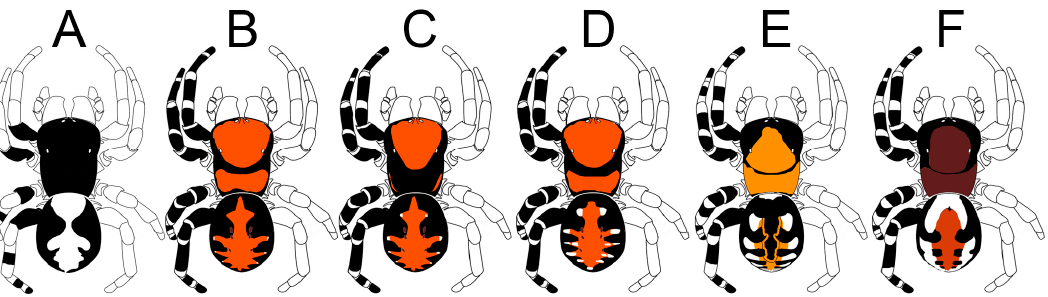
Figure 2. Male coloration patterns of six species of Loureedia . ( A ) L . colleni ; ( B ) L . maroccana ; ( C ) L . lucasi ; ( D ) L . jerbae ; ( E ) L . annulipes ; ( F ) L . phoenixi .